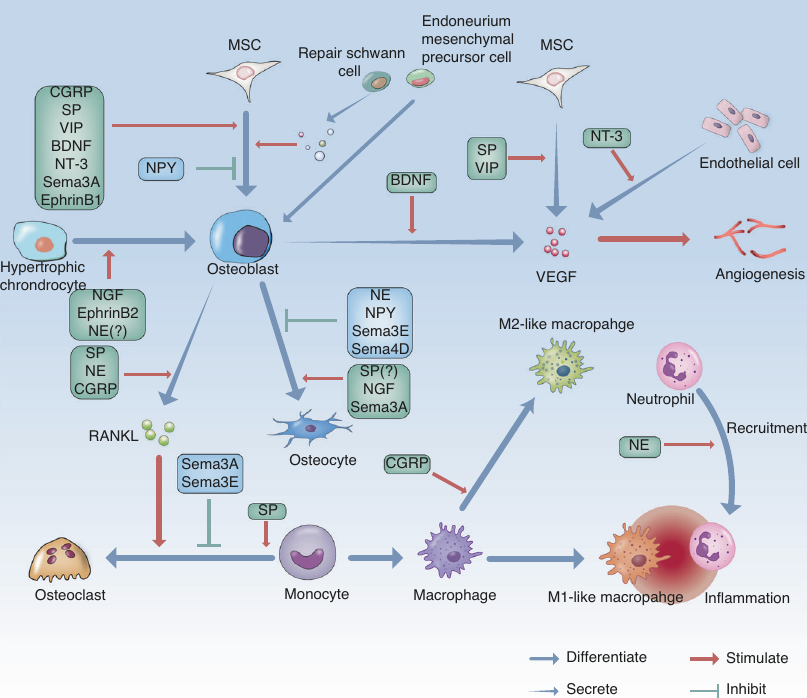
Fig. 4 Illustration showing how PNS nerve fi bers regulate bone regenerative processes following injury. The basic regeneration processes are represented by blue arrows. Neuropeptides or neurotransmitters positively or negatively regulate osteoblastic differentiation in MSCs, osteoclastogenesis in monocytes, tube formation by endothelial cells, type switching in macrophages and the recruitment of immune cells during the in fl ammatory phase of bone regeneration. Dedifferentiated SCs and endoneurium mesenchymal precursor cells contribute to new bone formation via direct osteoblastic differentiation or indirect secretion to stimulate the differentiation of MSCs. Red arrowheads represent a stimulatory effect, while green fl atheads represent an inhibitory effect. Green boxes contain stimulative neuropeptides or neurotransmitters for the corresponding process, and blue boxes contain suppressive neuropeptides or neurotransmitters. “ ? ” indicates that more reliable evidence is needed. CGRP calcitonin gene ‐ related peptide, SP substance P, NE norepinephrine, NPY neuropeptide Y, VIP vasoactive intestinal peptide, NGF nerve growth factor, BDNF brain-derived neurotrophic factor, NT-3 neurotrophin-3, Sema3A Semaphorin 3A, Sema3E Semaphorin3E, Sema4D